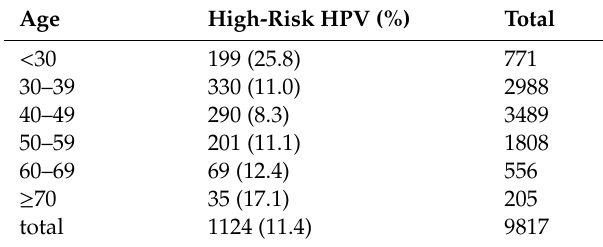
Table 7. Age related prevalence of HPV in the BD Onclarity ™ HPV assay